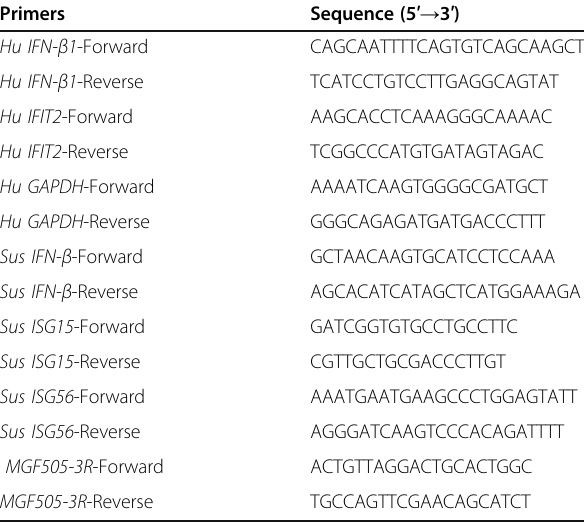
Table 1 The primer sequences for